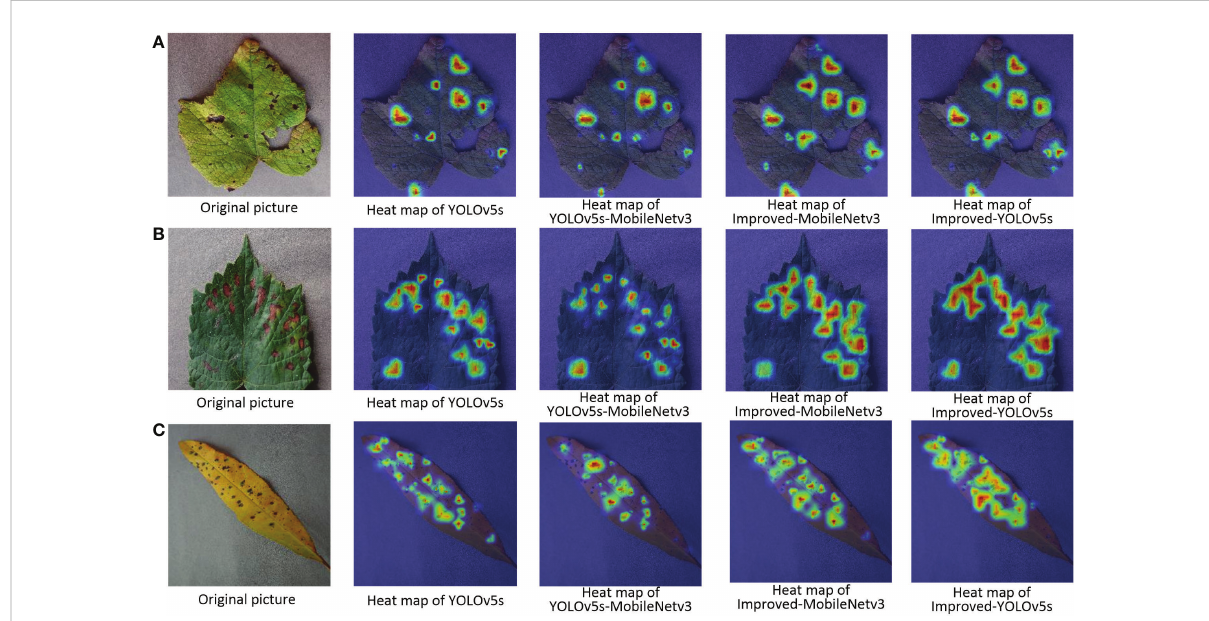
FIGURE 11 Pictures of the heat map detection of diseased leaves under different backbone networks. (A) Grape Leaf Blight; (B) Grape Black Measles; (C) Peach Bacterial Spot.